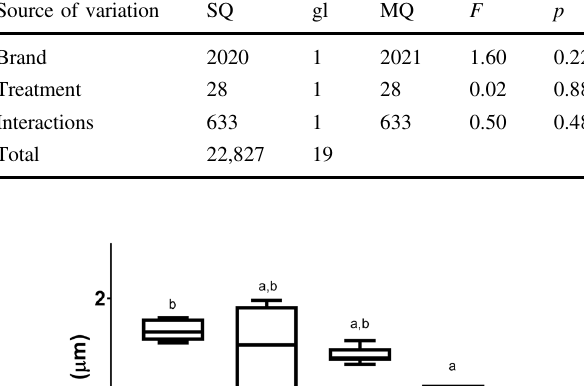
Table 3 Results of the ANOVA two-way statistical test of VH Source of